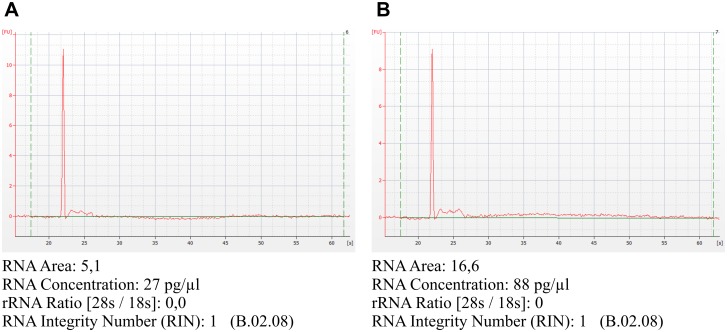
Total RNA in preparations of urine EVs.Bioanalyzer traces of total RNA from ERV fraction of the urine of HD (A) and PCa patient (B). The data from Agilent 2100 Bioanalyzer with 25 nt RNA fragment as an internal standard.